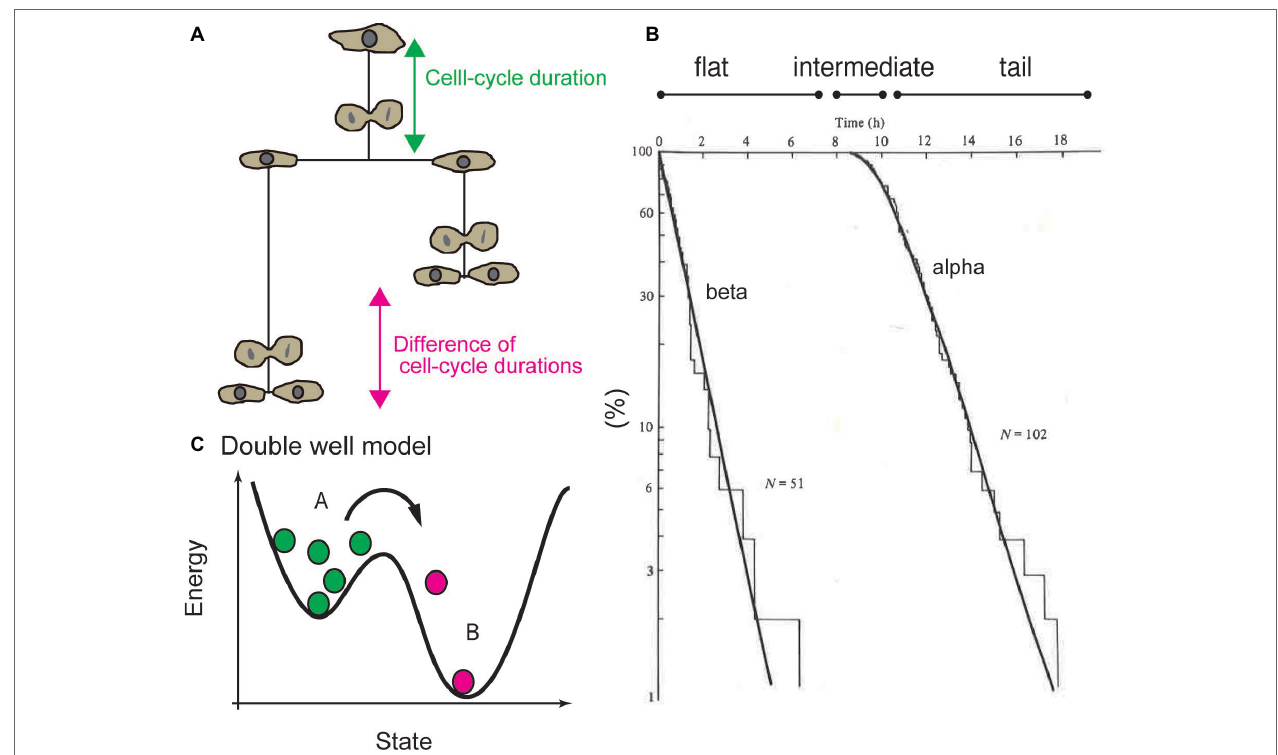
FIGURE 1 | Exponential tail of distribution of cell-cycle duration and transition probability model. (A) Cell-cycle duration (the period from completion of the previous round of division or release from the quiescent state to the next round of cell division) or the difference between of cell-cycle durations between sister cells were used to study statistical property of CDC. (B) Cumulative histogram of cell-cycle duration, or waiting time distribution. Tail of the waiting time distribution is called the alpha curve. Distribution of the difference of the cell-cycle duration between sister cells is called the beta curve. Waiting time distribution is divided into the flat region, intermediate (or convex) region, and exponential tail. (C) Double well model to explain mechanism of transition probability model, the exponential tail of the waiting time distribution is interpreted based on the probability of reaction kinetics of each single molecule. For example, radioactive molecules (green circles) become nonradioactive (magenta circles) in a certain probability in a certain period. In this model, “old” radioactive molecules are equally likely to lose radioactivity as “young” molecules. Panel (C) is reused with permission from Cambridge University Press (Brooks,